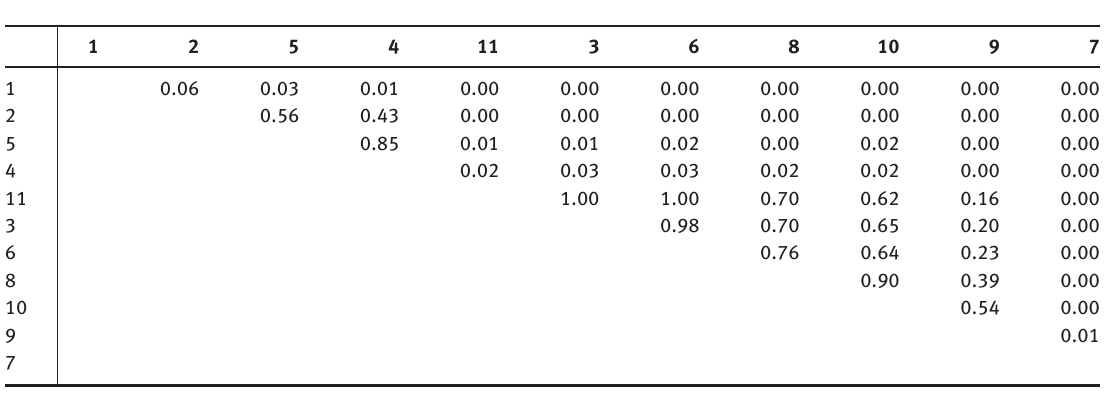
Table 5: The p -values for unconditional pairwise tests.